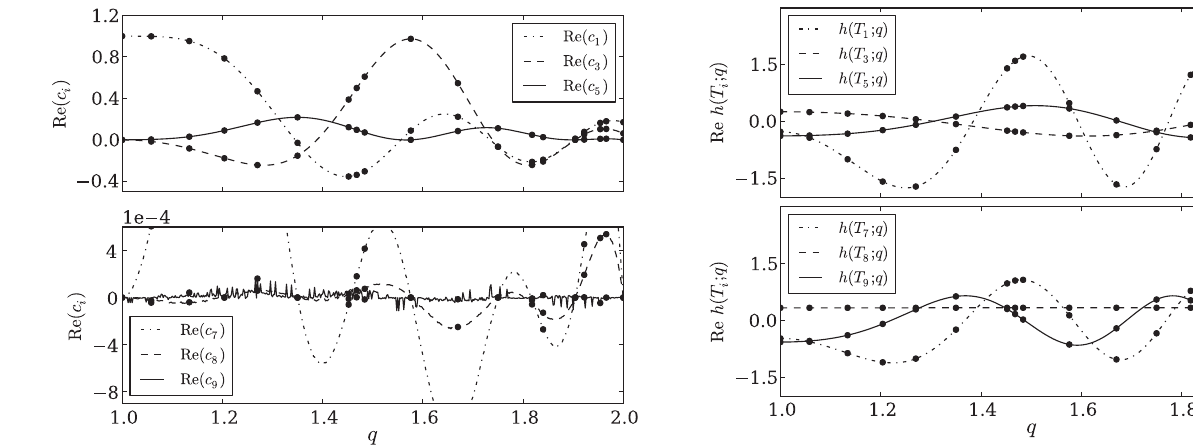
FIG. 16. The curves depict a variety of projection coefficients c q Þ along with the greedy data as a function of mass ratio for i ð our EOB example case introduced in Sec. III. Only a represen- tative few curves are shown. The top panel shows the kind of structure that the coefficients have, thereby preventing accurate global (polynomial) fits without additional data points. The bottom panel shows the transition in the behavior of these functions with mass ratio from smooth to noisy.